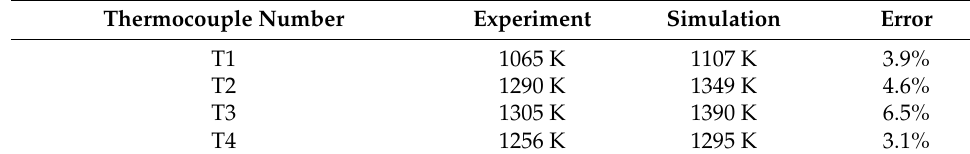
Table 4. Comparison of experimental and numerical simulation results.